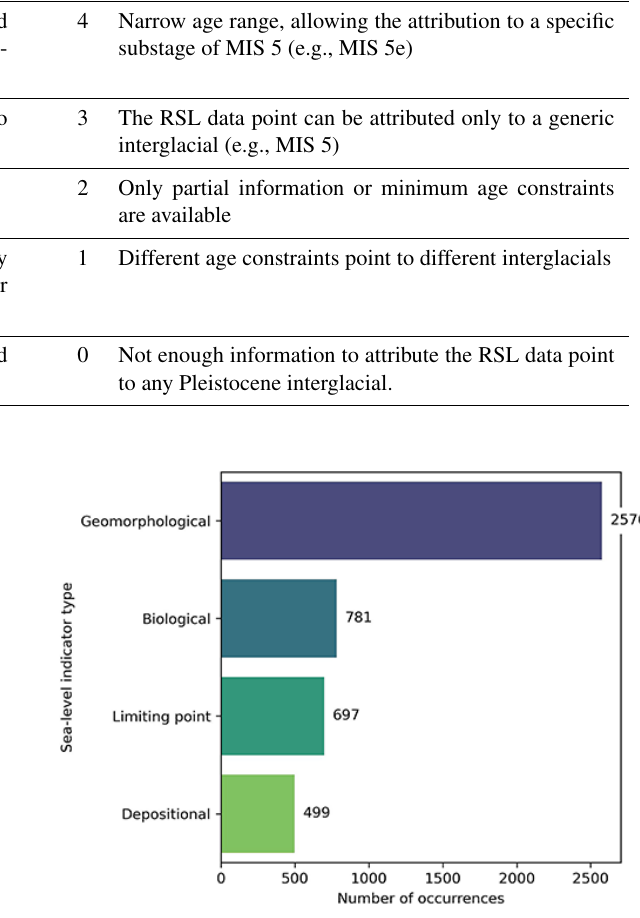
Figure 8. Percentage of occurrence in WALIS of main categories of sea-level proxies. The code used to create this image is available from Rovere et al.